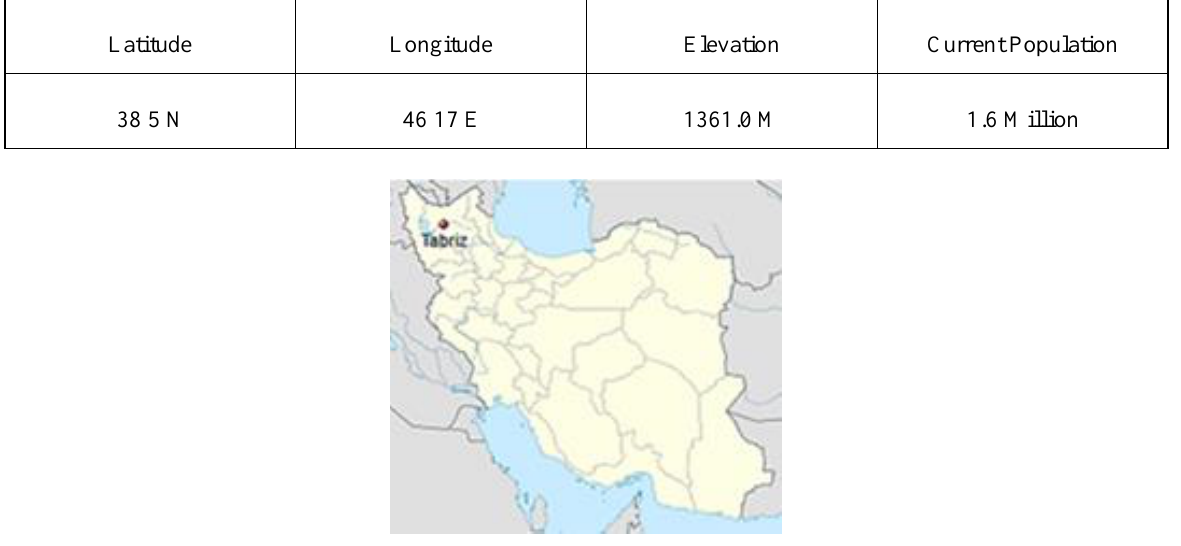
Figure 1 Tabriz on Iran’s map (Source: www.